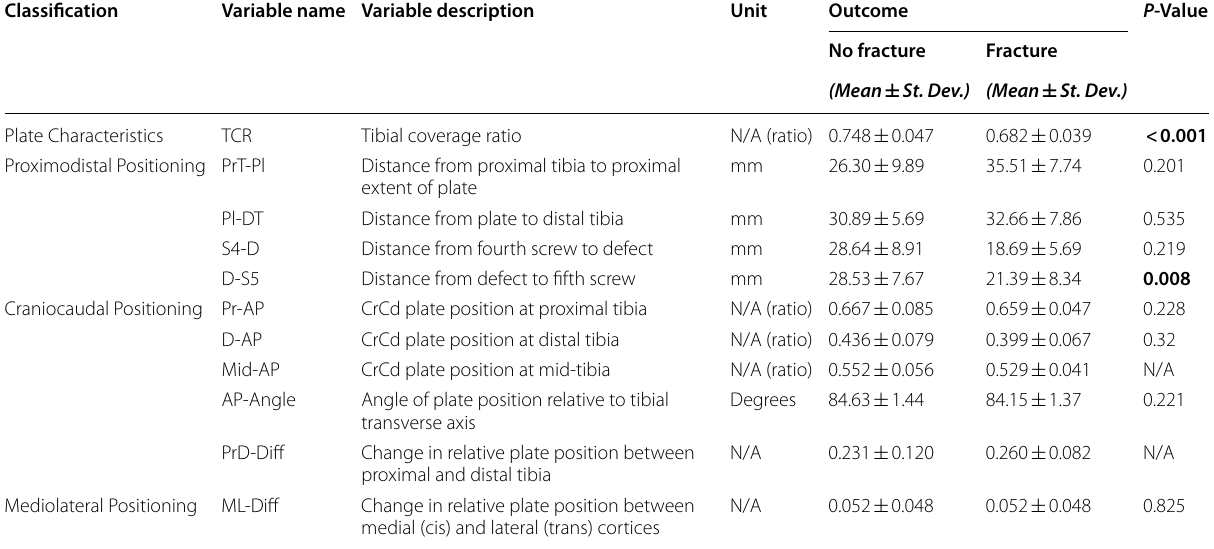
Table 4 Plate characteristics and positioning variables identified on radiographic and computed tomographic examination and their association with fracture complication